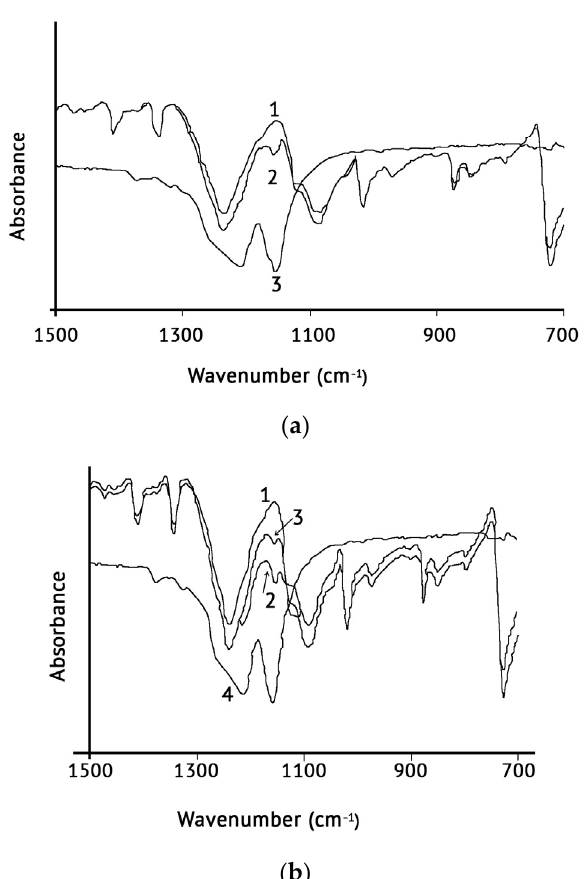
Figure 1. IR absorption spectra (MATR method): ( a ) 1 is the initial polyester fabric; 2 is the fabric processed in SC-CO 2 with UPTFE FORUM ® at a pressure of 20 MPa and temperature of 90 ◦ C; 3 is UPTFE FORUM ® ; ( b ) 1 is the initial polyester fabric; 2 is the fabric processed with a TFE/AC solution; 3 is the fabric processed with a TFE/BC solution; 4 is PTFE.